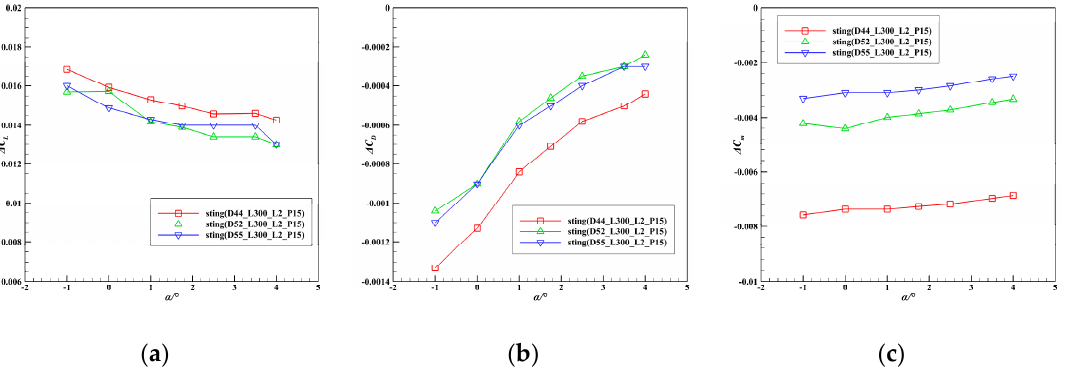
Figure 7. Support interference results from the BWB aircraft with different straight-section diameters (D = 44 mm / 52 mm / 55 mm, Ma = 0.75): ( a ) C L - α curves; ( b ) C D - α curves; ( c ) C m - α curves.